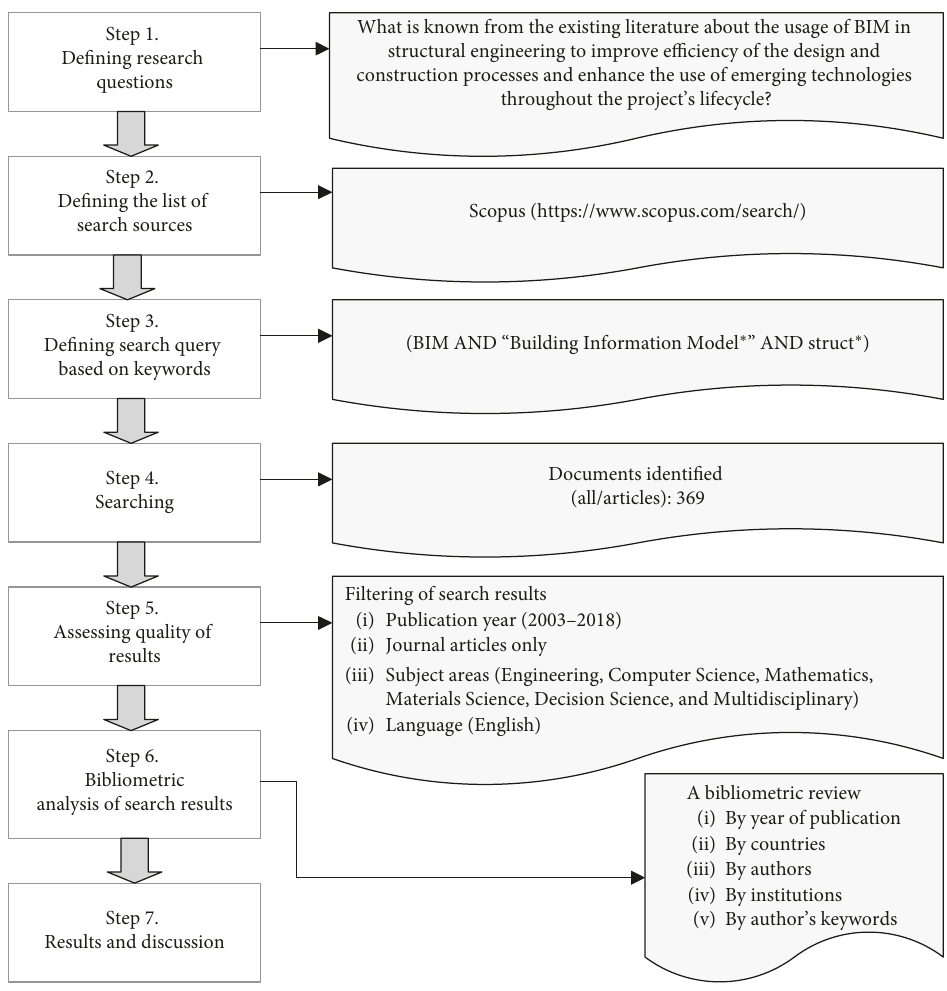
Figure 1: Research design for bibliometric analysis of retrieved papers.